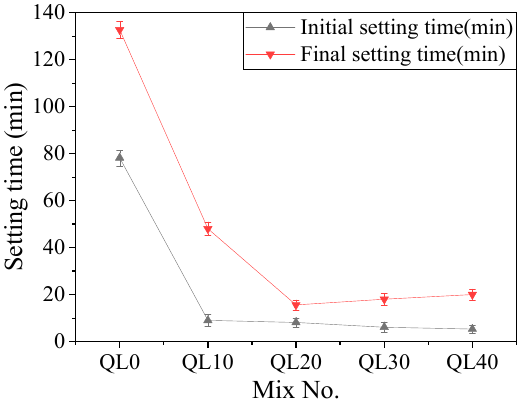
Figure 2. Effect of quicklime on the setting time.